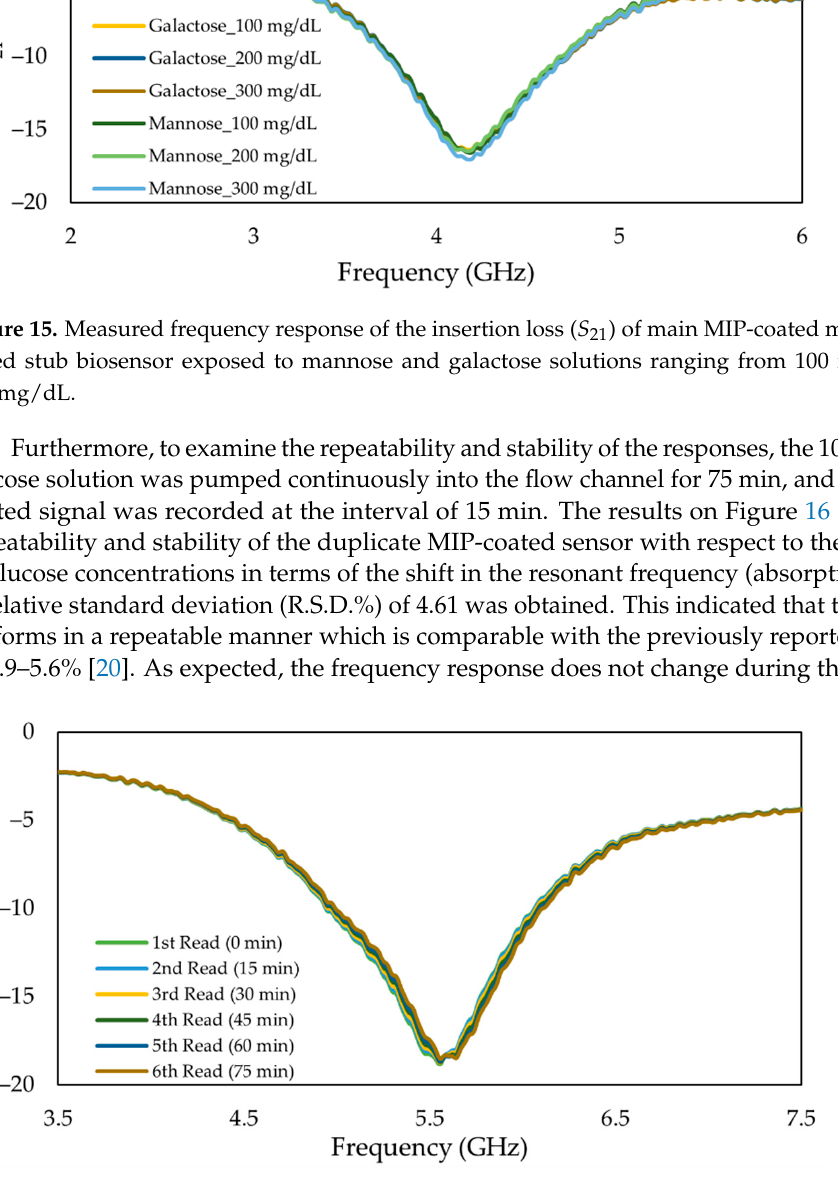
Figure 16. Repeatability and stability test for frequency changes in the duplicate MIP-coated microwave-based stub biosensor: Frequency response exposed to 100 mg/dL glucose solution.